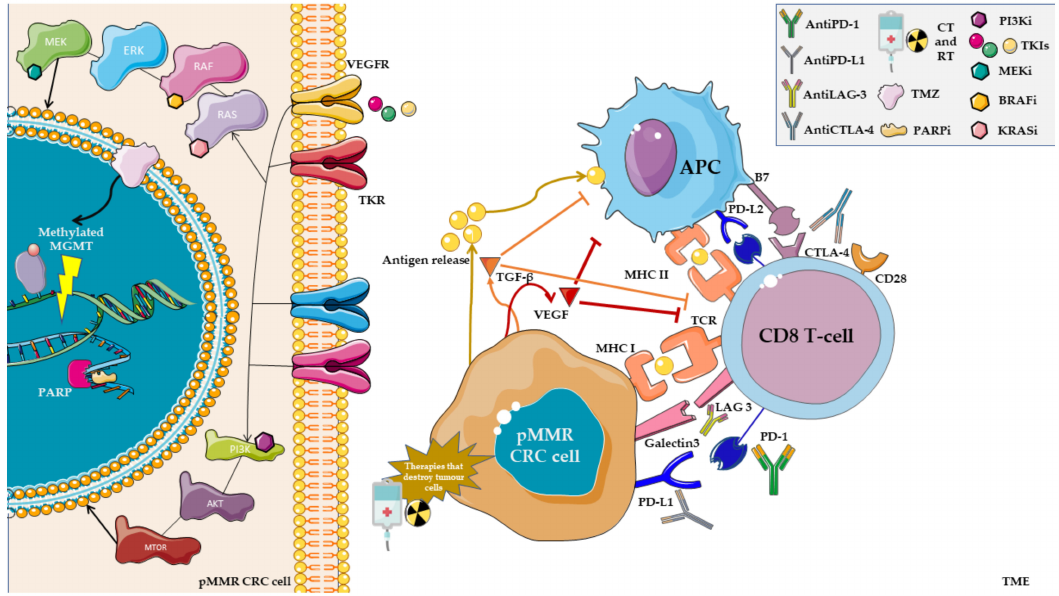
Figure 1. Among the current challenges described in combination with ICIs, we can distinguish the use of therapies that aim to release neoantigens to activate the immune system, such as chemotherapy (CT), targeted therapy, or radiotherapy (RT). Other methods to cope with the inherent resistance to ICIs, such as temozolomide (TMZ) or PARP inhibitors (PARPi), operate by creating a temporary MSI status. The use of tyrosine-kinase inhibitors (TKIs) that target VEGFR in combination with ICIs has had favorable results in other malignancies, with modulation over the TME in addition to the known antitumoral effect. Additionally, blocking TGF- β and VEGF may have a role in promoting ICI activity in these tumors. Meanwhile, there are rationales for combination with inhibitors of the main steps of the MAPK or PIC3KA